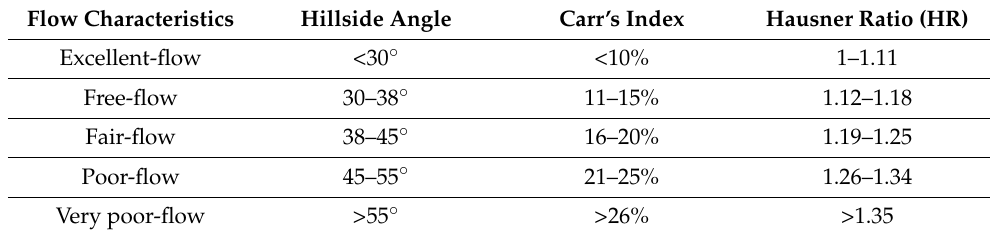
Table 3. Flowability characteristics in relation to the hillside angle, Carr’s classification, and the HR